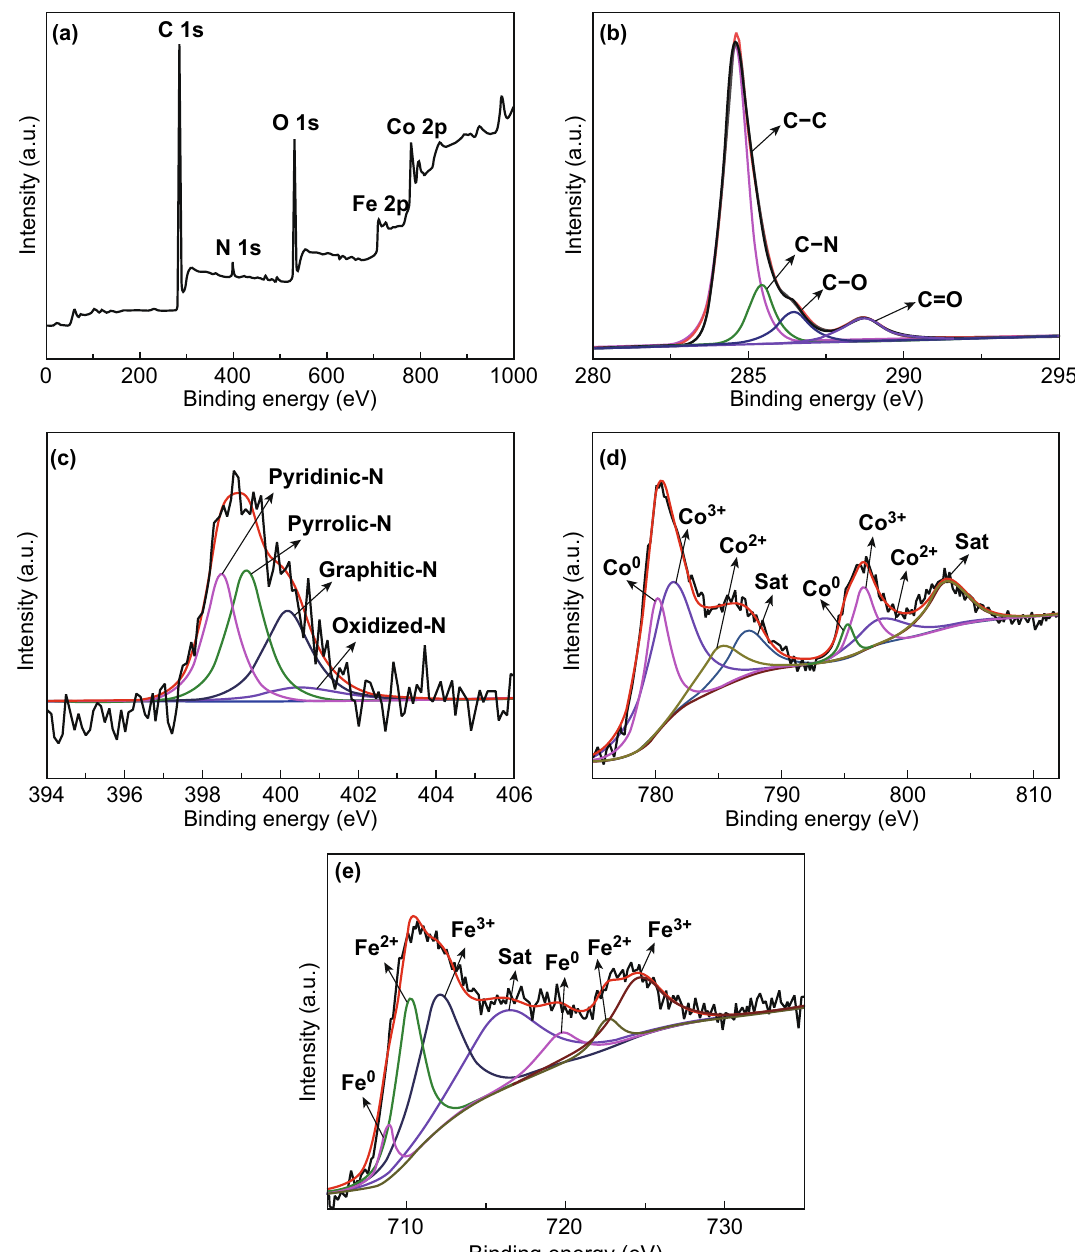
Fig. 5 XPS spectra of Fe–Co/NC/rGO of a survey scan, b C 1s, c N 1s, d Co 2p, and e Fe